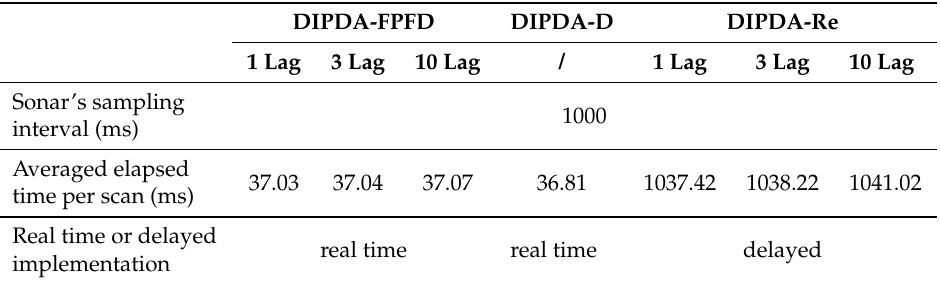
Table 4. Computational complexity of each compared method (take case 2 for